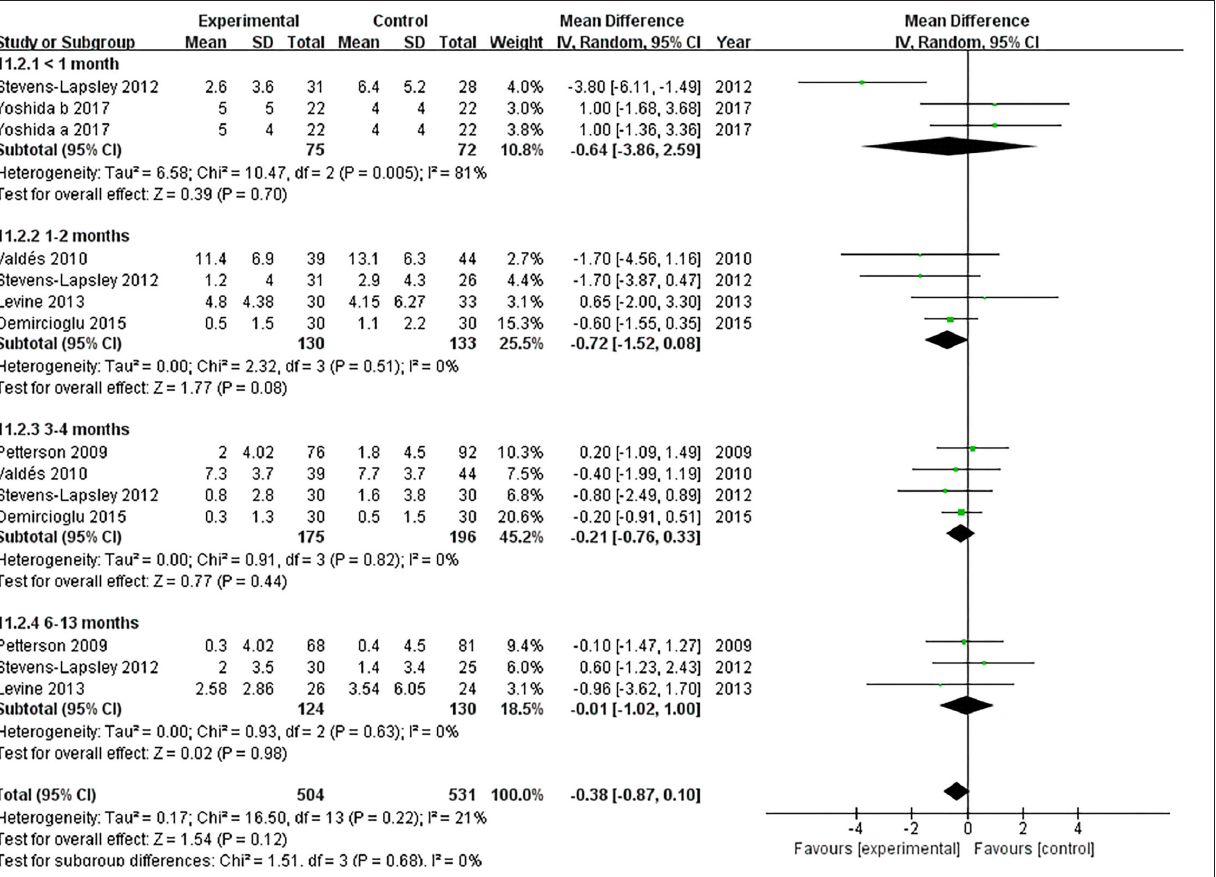
FIGURE 13 | Forest plots of meta-analysis of the effect of NMES vs. conventional rehabilitation on knee extension.